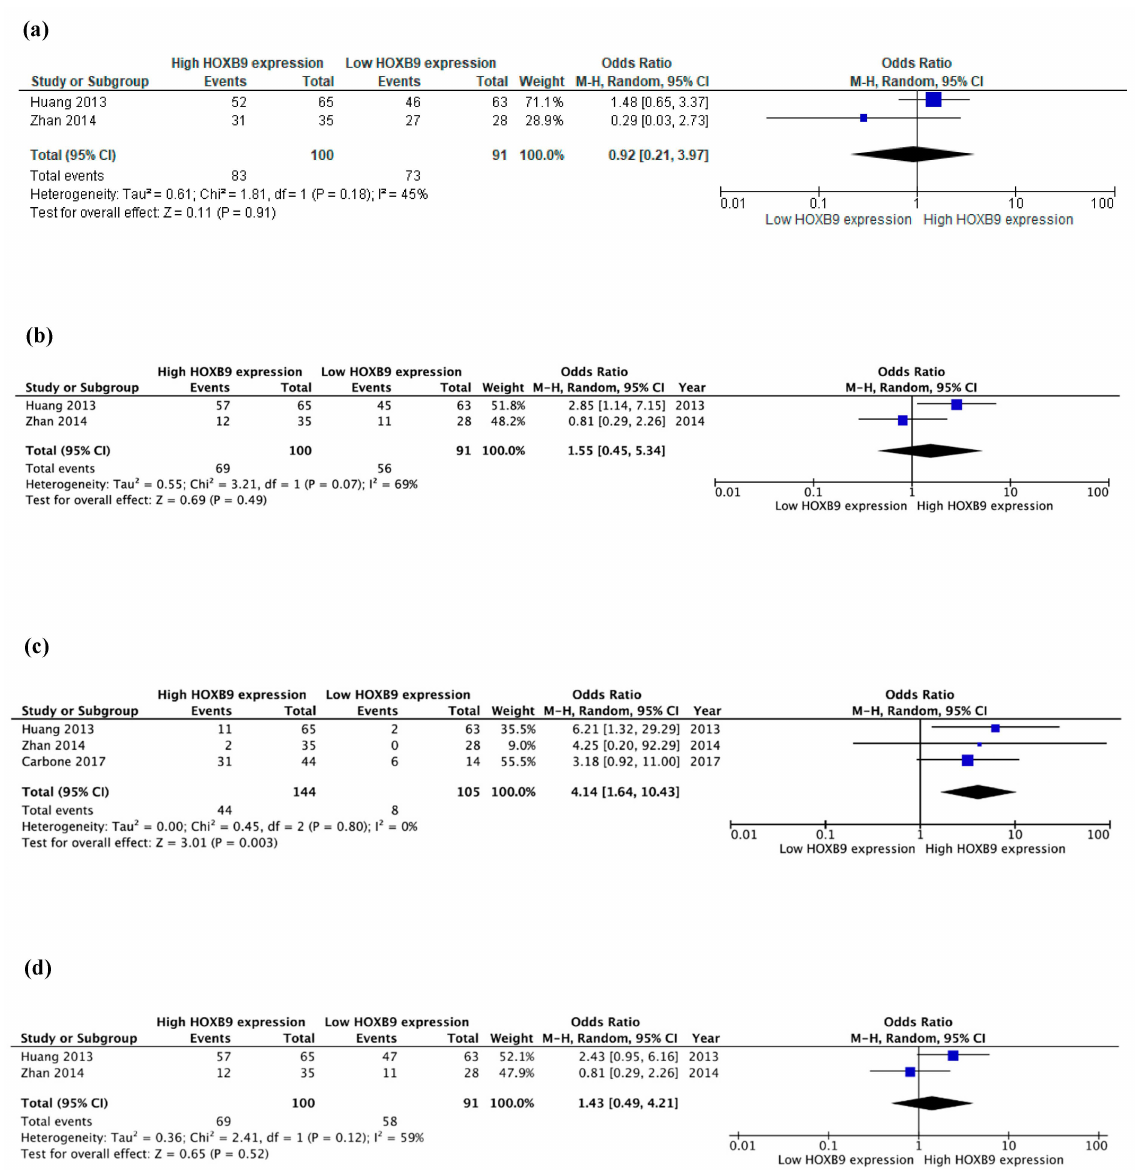
Figure 3. Forest plots of included trials assessing the effect of HOXB9 expression on ( a ) tumour depth, ( b ) lymph node invasion, ( c ) presence of metastatic disease, ( d ) advanced stage of CRC. Odds ratios and 95% confidence intervals (95% CIs), were pooled using random-effect meta-analysis. Blue squares indicate the effect size for each study (ORs between high and the low HOXB9 expression group) and the length of the lines indicate the 95% CIs. The size of the square represents its weight in the analysis. The black diamond on the bottom of the forest plot indicates the overall weighted effect size. I 2 indicates between-study heterogeneity. Detailed characteristics of each study are available in Table 1 of the main manuscript (M-H: Mantel Haenszel, CI: confidence